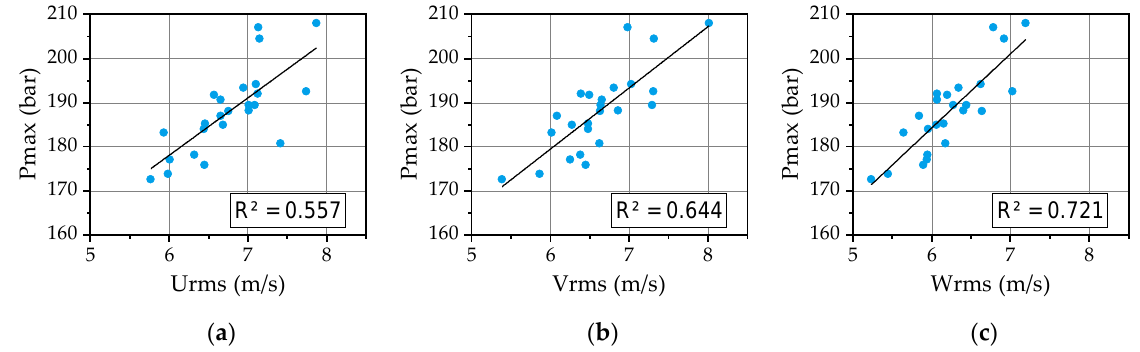
Figure 16. Peak pressure (P max ) as a function of the cylinder-averaged RMS velocities ( a ) U and ( b ) V parallel to the cylinder head and ( c ) W in the direction of the piston axis evaluated at the start of injection.